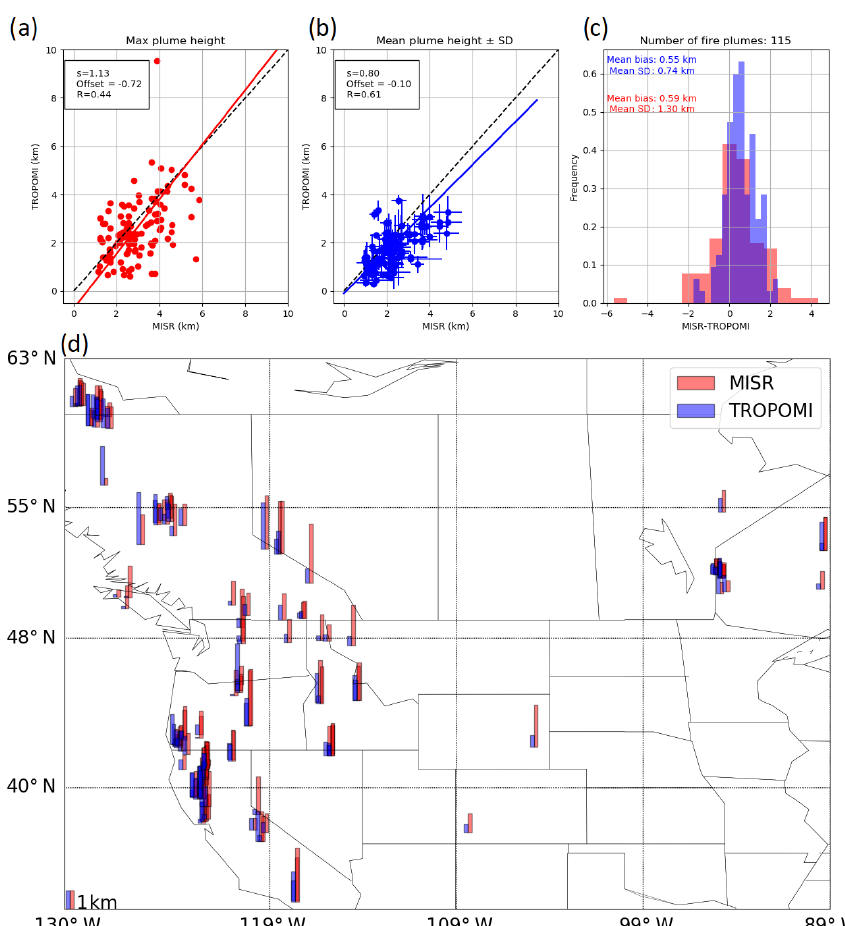
Figure 3. TROPOMI–MISR plume height comparison. In total 115 fire plumes were compared (all between June and August 2018) in terms of (a) maximum plume height and (b) mean plume height within one wildfire plume, together with the statistics of the line of best fit (correlation coefficient, R , and slope, s ). Panel (c) shows the histogram for the differences in plume height (MISR − TROPOMI) for the maximum (blue) and mean (red) plume height. (d) A map showing the regional distribution of those fires with the mean plume height (above ground level) for TROPOMI (blue; left bar) and MISR (red; right